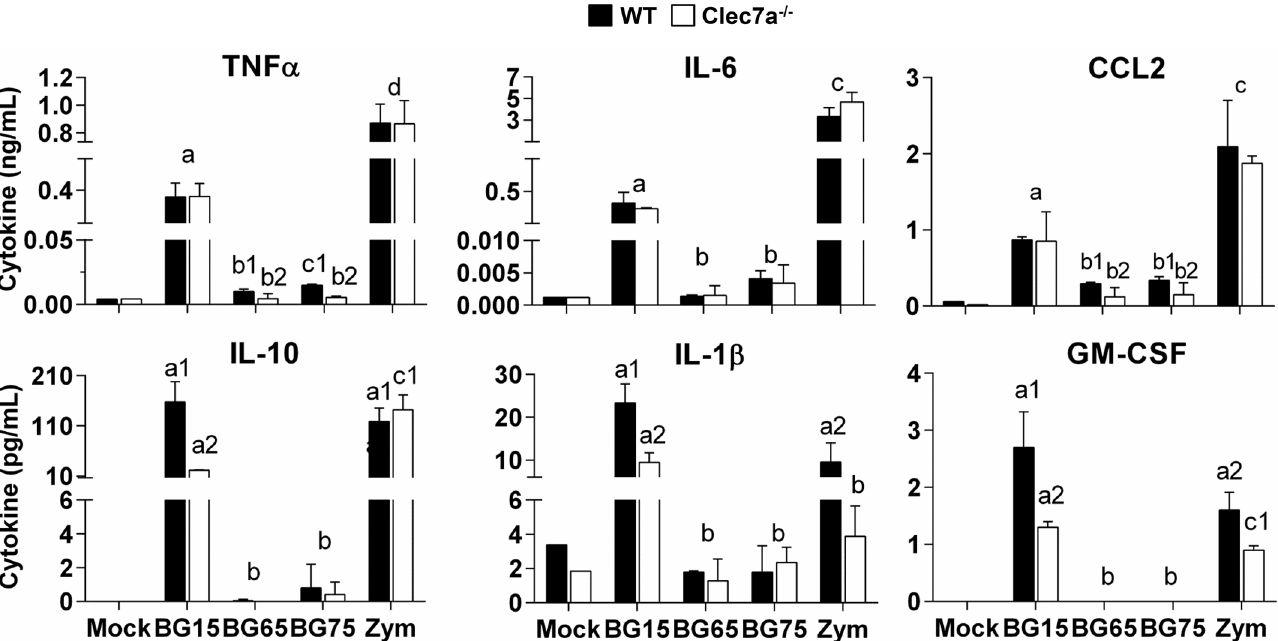
Fig 6. Sc cell wall crude products- and zymosan-induced cytokine productions are mainly dectin-1-dependent. WT and Clec7a -/- BMDM were stimulated with Sc extracts enriched in BG for 8 h. After incubation, cell culture supernatants were harvested and stored at -20°C. Chemokines and cytokines (TNF α , IL-6, CCL2, IL-10 and IL-1 β ) were quantified using a customized multiplex assay and GM-CSF was measured with a cytokine detection kit. Data are expressed as the mean ± SD of three independent experiments performed in triplicate. Mean values not sharing the same letter are significantly different according to the Student ’ s t-test ( p <